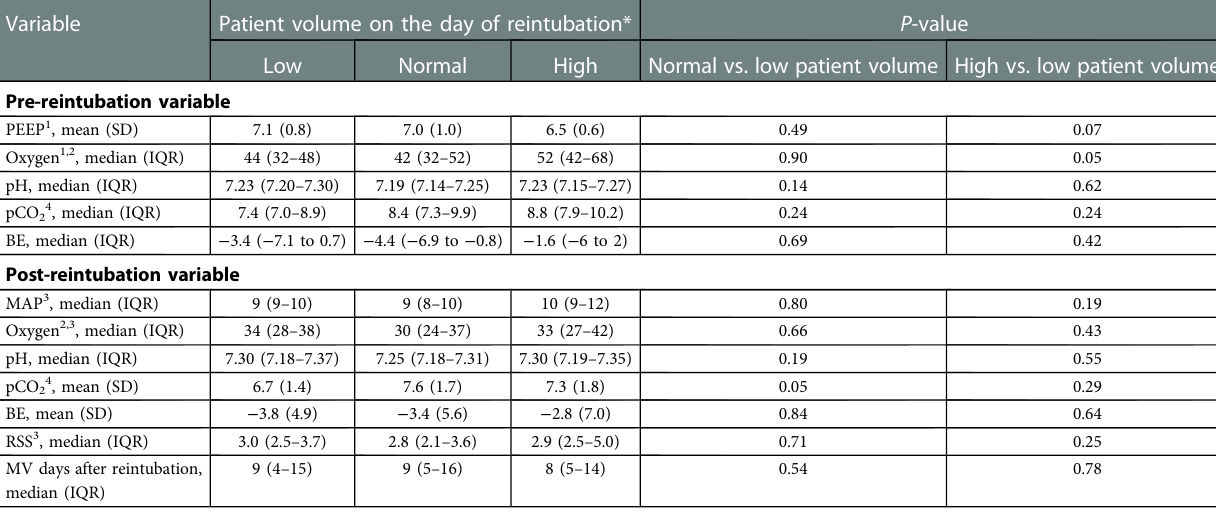
TABLE 4 Indicators of short-term respiratory morbidity for infants reintubated and associations with patient volume, n =143. Variable Patient volume on the day of